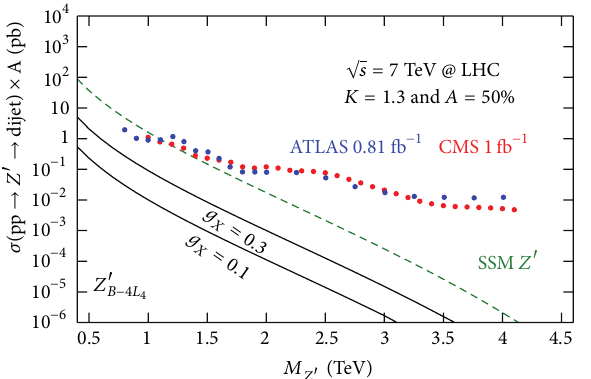
Figure 7: The constraints on 𝑍 󸀠 in the dijet search from CMS (red dots) with integrated luminosity of 1fb −1 and from ATLAS (blue dots) with integrated luminosity of 0.81 fb −1 . The predicted events at with a range of coupling LHC through the 𝑍 󸀠 boson of the 𝑈(1) 𝐵−4𝐿 4 constant (for instance, 𝑔 𝑋 = 0.3 ) lie below the current reach of the CMS and ATLAS data. Also plotted is the predicted signal from the sequential 𝑍 󸀠 model (green dashes), for comparison. See [11] for references and details. Figure from